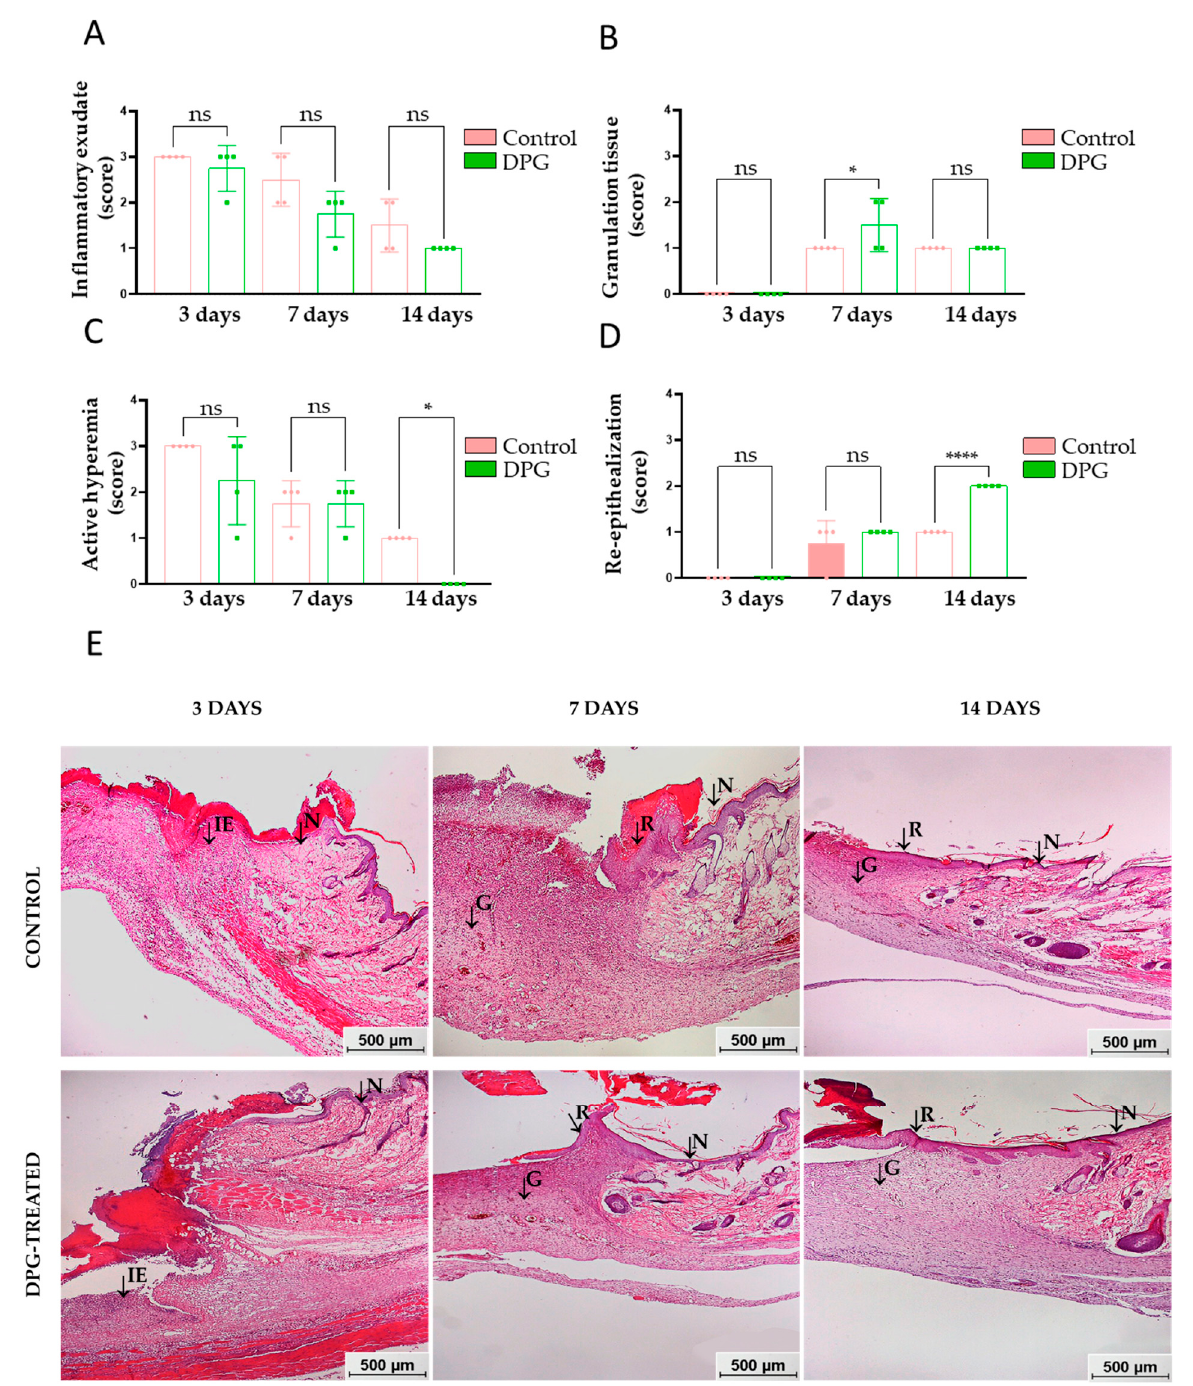
Figure 2. Semi-quantitative characteristics of wound healing areas at days 3, 7, and 14 of experimen- tation. ( A ) Inflammatory exudate; ( B ) active hyperemia, DPG vs. Control, day 14 (* p < 0.05); ( C ) granulation, DPG vs. Control, day 7 (* p < 0.05); ( D ) re-epithelialization, DPG vs. Control, day 14 (**** p < 0.0001); ( E ) representative histological images of the wound healing areas of the animals. Note the presence of normal tissue (N), inflammatory exudate (IE), granulation tissue (G), and re- epithelialization tissue (R). HE staining: 50× magnification (bar = 500 μ m). Concerning total collagen, at days 3 and 7, although there was no significant differ- ence, a relatively higher density of total collagen content was observed in the DPG group.